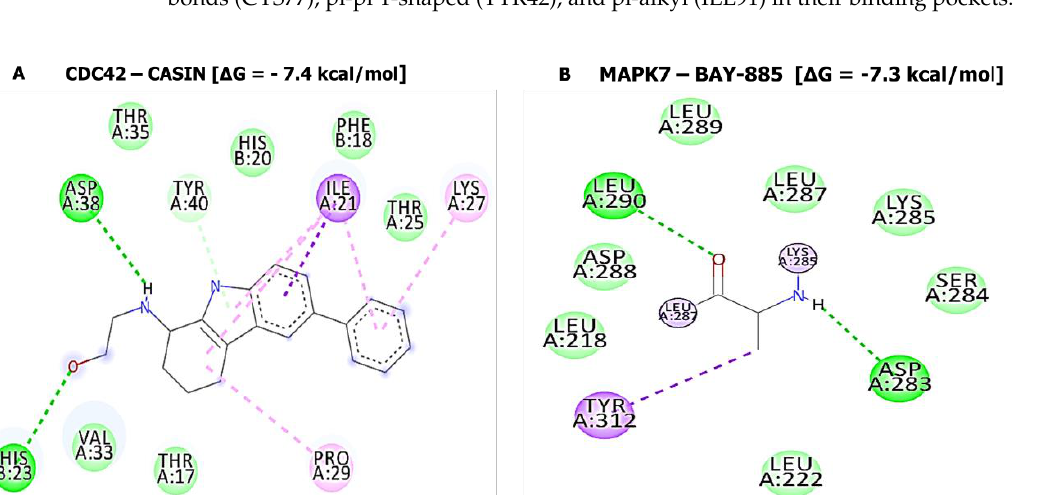
Figure 11. In silico docking results of SJ10 in complex with the CCNB1, CDC42, MAPK7, and CD44 oncogenes in 2D representations. ( A ) The CCNB-SJ10 complex exhibited a putative binding energy of − 7.9 kcal/mol, and displayed interactions by conventional H-bonds (green) with ALA128 and ARG68, and short binding distances of 2.07 and 2.73 Å, respectively. ( B ) The CDC42-SJ10 complex showed a binding energy of − 7.8 kcal/mol, and displayed van der Waals interactions (THR25, PHE28, SER30, THR17, and TYR40), pi-sigma (ILE21), and pi-alkyl (PHE18, LYS27, and PRO29) in their binding pockets. ( C ) The MAPK7-SJ10 complex displayed a unique binding energy of − 8.4 kcal/mol, and further showed conventional hydrogen bonds (SER153), with a shorter binding distance of 2.23 Å. ( D ) The CD44-SJ10 complex showed a binding energy of − 7.8 kcal/mol, and exhibited van der Waals interactions (THR102, GLY103, ARG90, LEU70, TYR79, SER71, ILE96, and ARG78), carbon hydrogen bonds (CYS77), pi-pi T-shaped (TYR42), and pi-alkyl (ILE91) in their binding pockets.